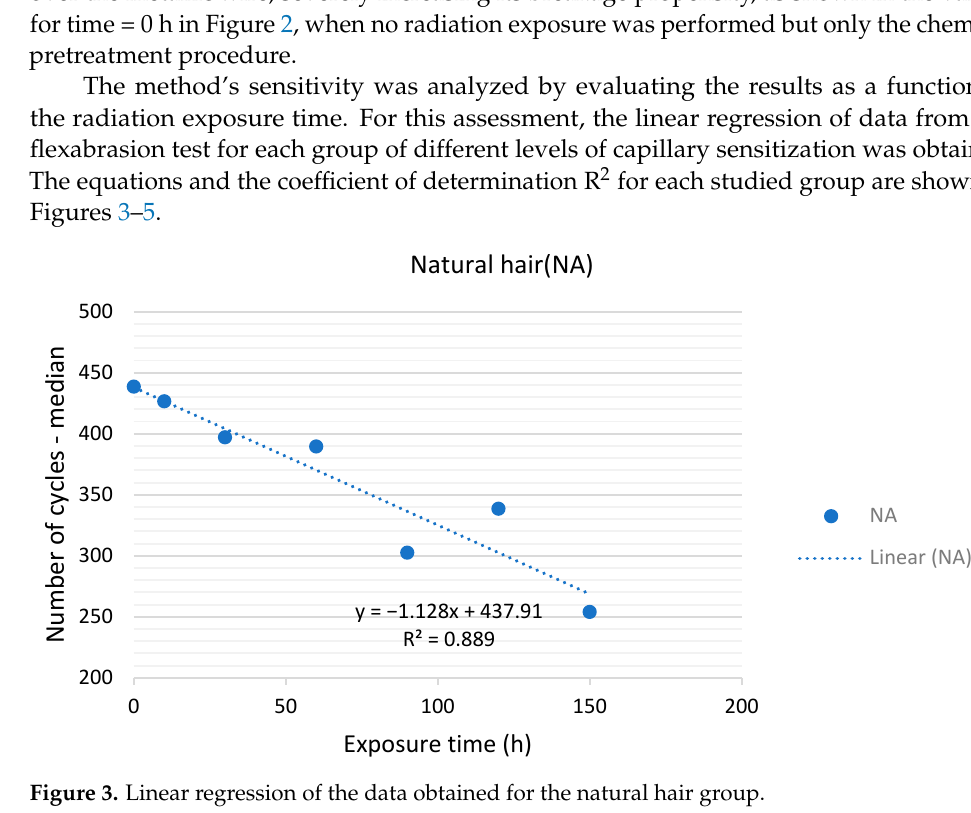
Figure 3. Linear regression of the data obtained for the natural hair group.